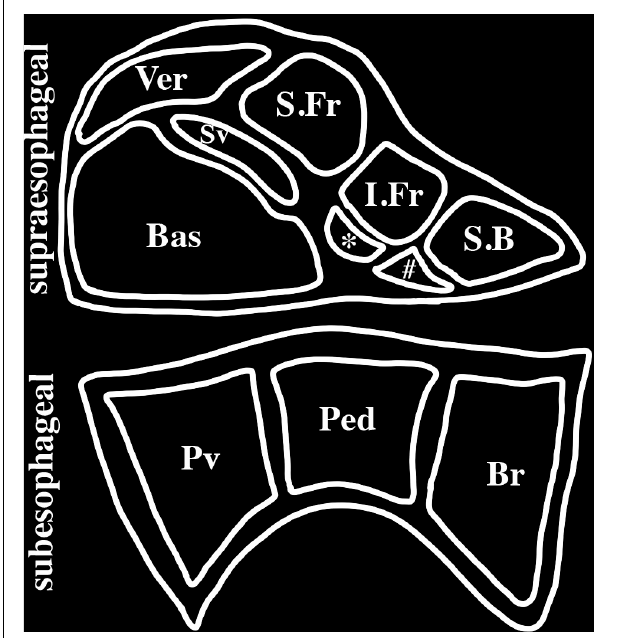
FIGURE 1 | Schematic representation of a mid-sagittal section of an octopus brain. The brain is encased in a cartilaginous capsule and consists of two principal regions: the supraesophageal region lying above the esophagus and the subesophageal region lying below the esophagus. The principal lobes of the midline supraesophageal region consists of the vertical (V), subvertical (Sv), superior frontal (S.Fr), inferior frontal (I.frontal), superior buccal (S.B), posterior buccal (#), subfrontal ( ∗ ) and basal (Bas) lobes. The inferior frontal consists of a median lobe (shown here) and a lateral lobe (not shown here) that is located lateral to the midline. The subesophageal brain is partitioned into three lobes: brachial (Br) which gives rise to the brachial nerves to the arms, pedal (Ped) and palliovisceral (Pv)